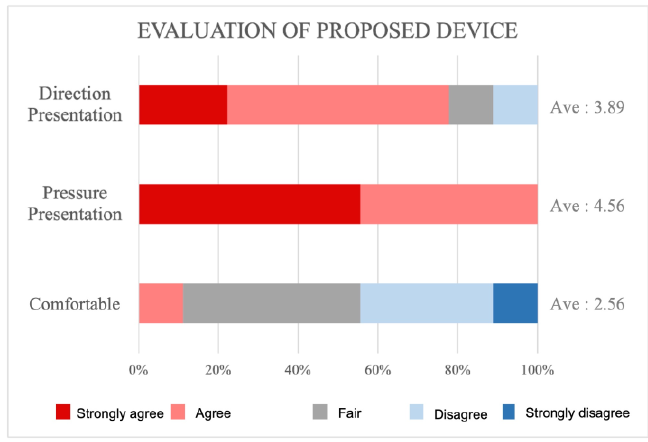
Figure 10. Survey